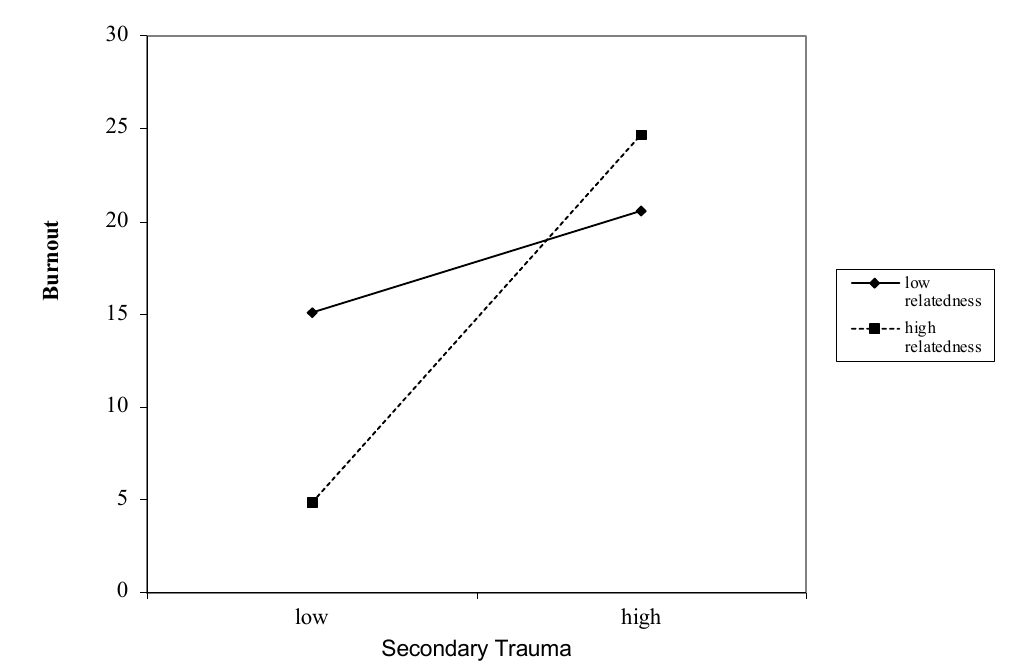
Figure 3. Graph of interaction plot between secondary trauma and relatedness. Perceived relatedness moderates the relationship between secondary trauma and burnout, such that those with low relatedness (1 SD below the mean) and high secondary trauma reported greater burnout.